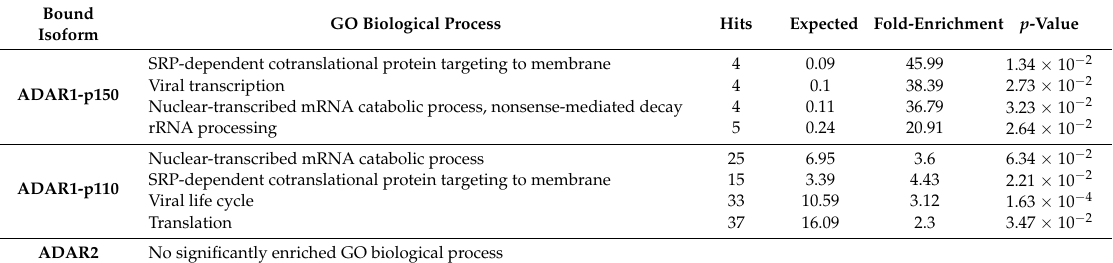
Table 2. Positively enriched gene ontology (GO) biological processes for ADAR-bound transcripts. Bound